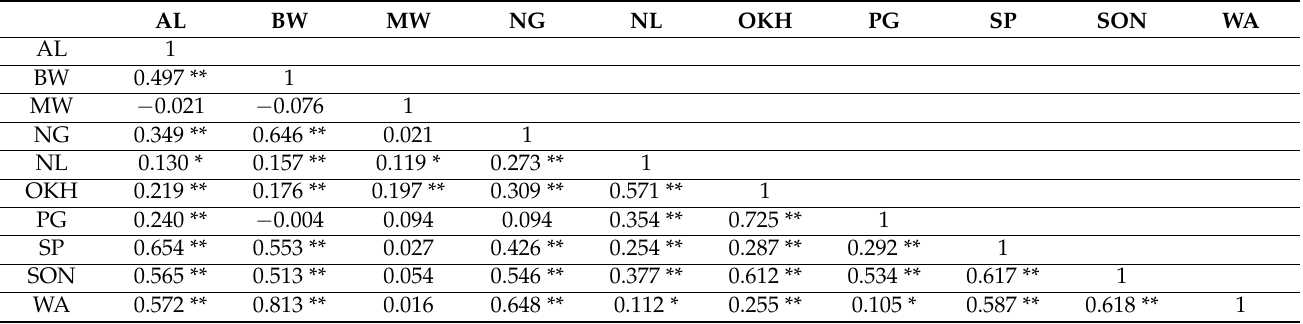
Table 4. Correlation between the different monitoring stations for the post-pandemic